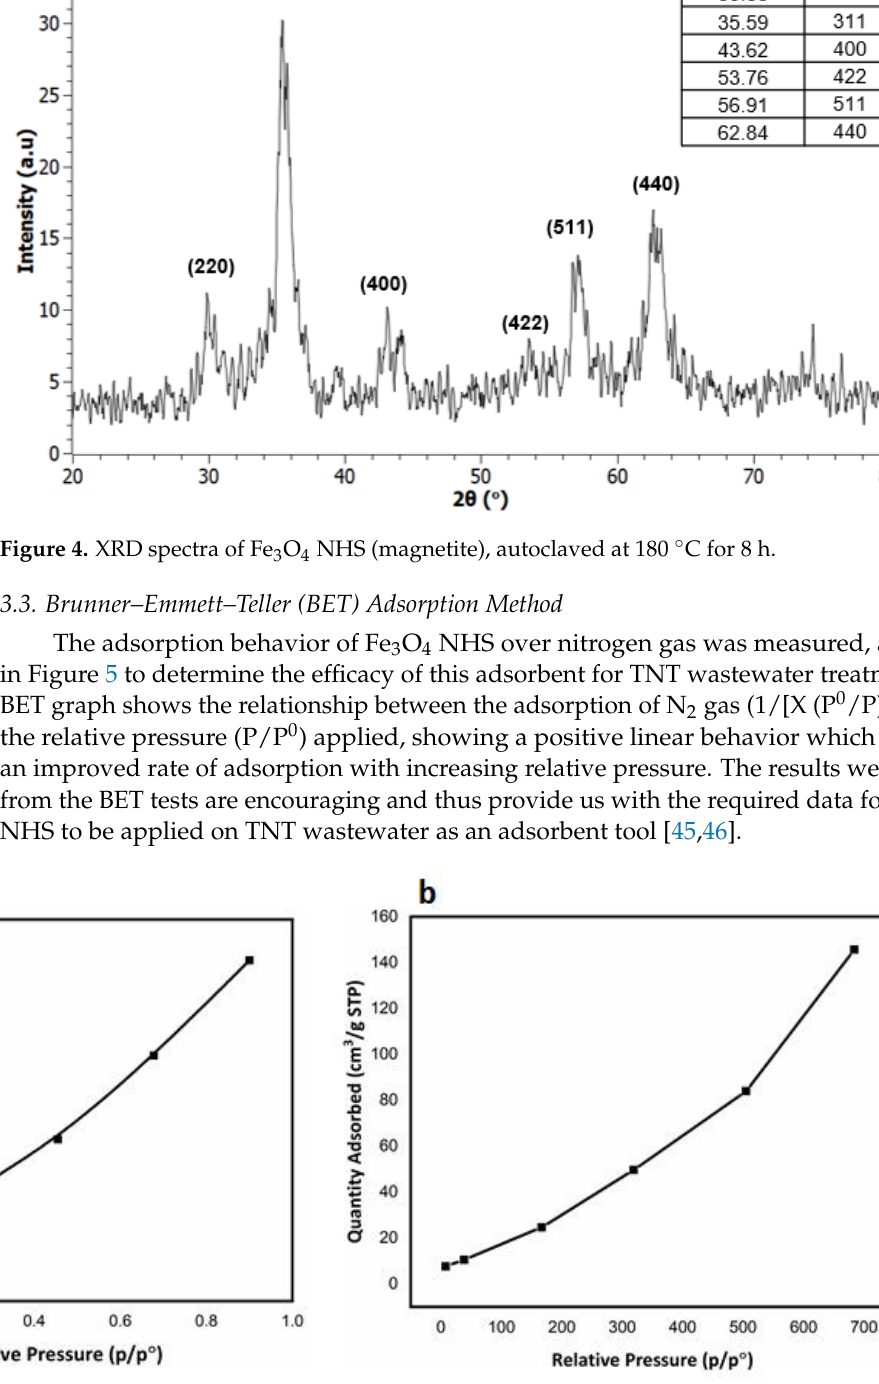
Figure 3. XRD spectra of α -Fe 2 O 3 (hematite), autoclaved at 160  C for 6 h.